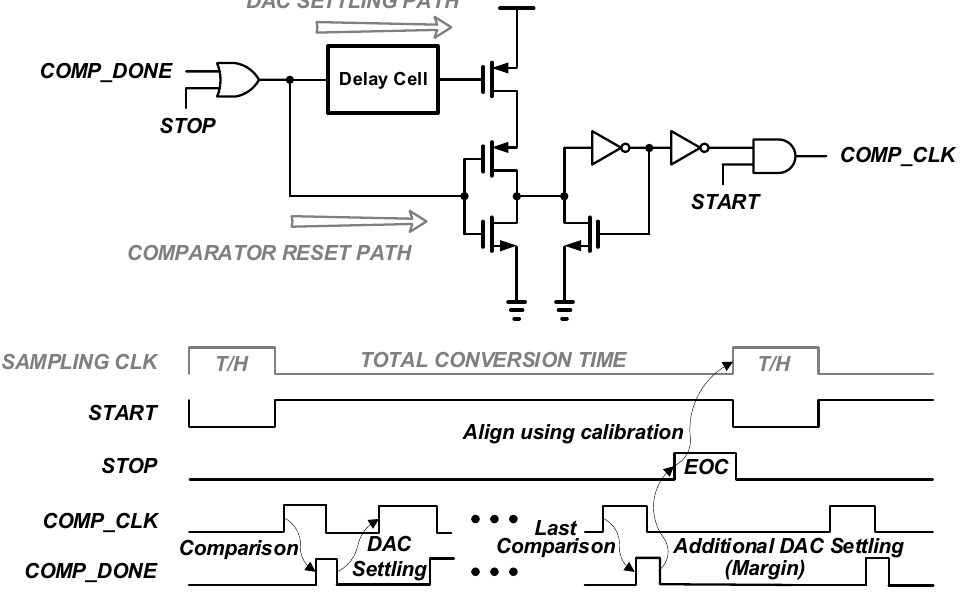
Figure 7. Loop delay circuit of asynchronous SAR ADC.